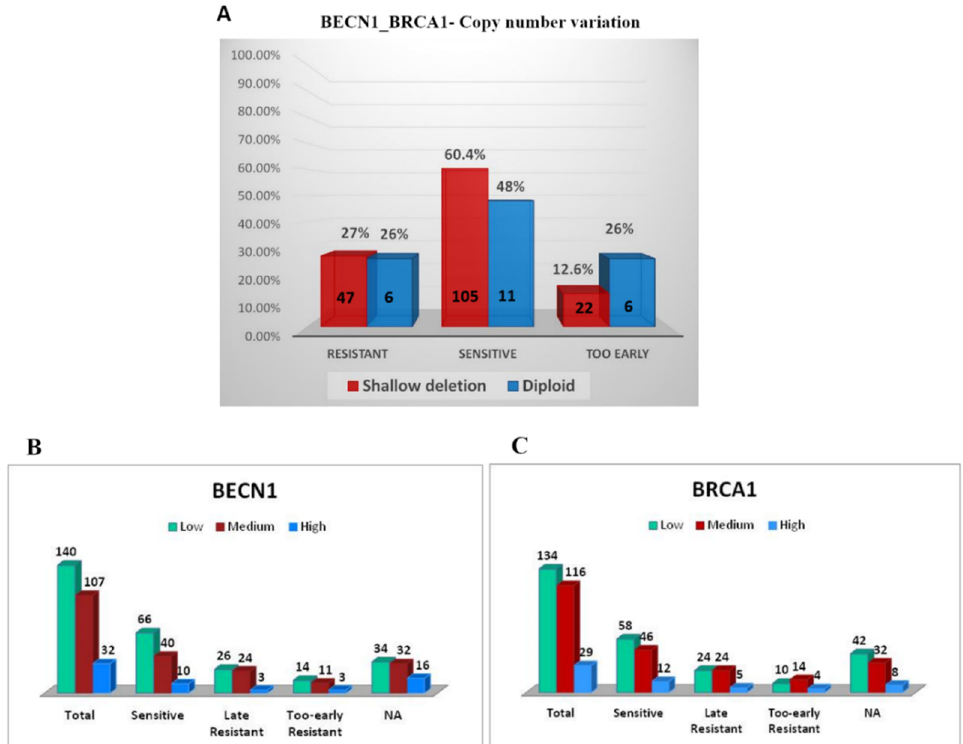
Figure 8. Concurrent low expression of BECN1 and BRCA1 correlates with platinum sensitivity. ( A ) Platinum sensitivity based on CNV of BECN1 and BRCA1 in TP53 -mutated patients. ( B ) Platinum sensitivity based on BECN1 mRNA expression. ( C ) Platinum sensitivity based on BRCA1 mRNA expression. All patients underwent primary cytoreductive surgery, followed by adjuvant platinum- based chemotherapy as first-line treatment. Platinum sensitivity: the time from adjuvant platinum- based treatment to cancer relapse (platinum-free interval, PFI) was >6 months. Late Resistance: resistance occurs after a 6-month-period. Too-early Resistance: resistance occurs as soon as treatment started (within 6